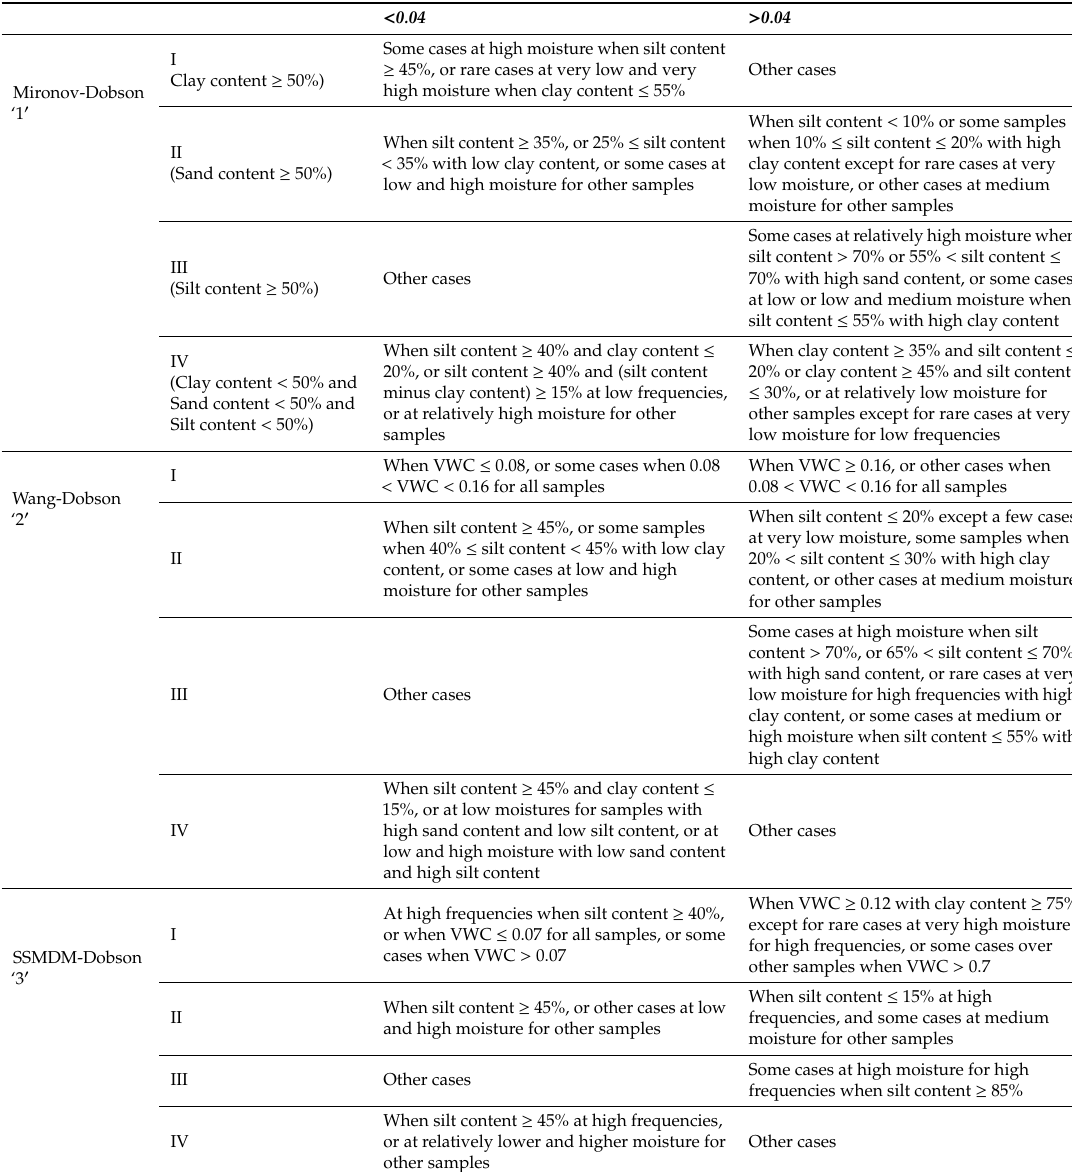
Table A1. Deviations induced by model discordance for all soil texture cases with volumetric